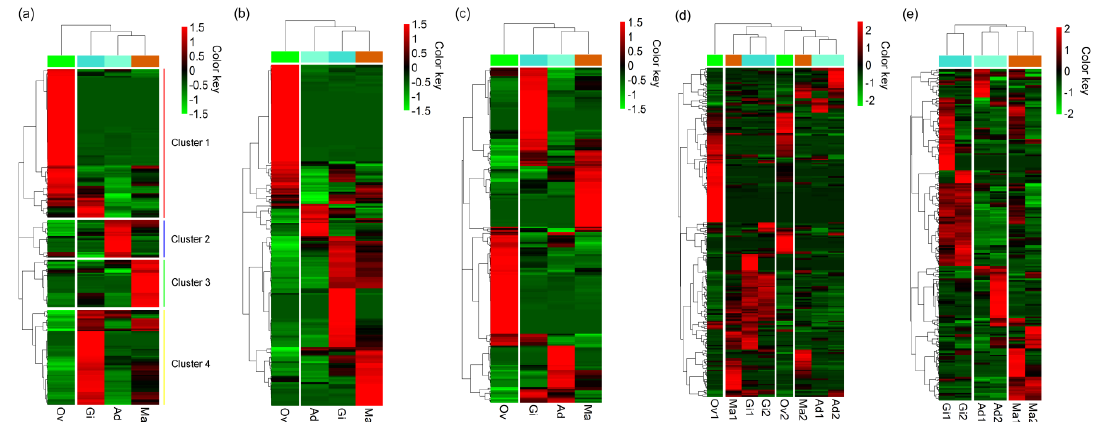
Figure 3. Heat map of expression levels of miRNAs in P. fucata somatic and ovary tissues, based on